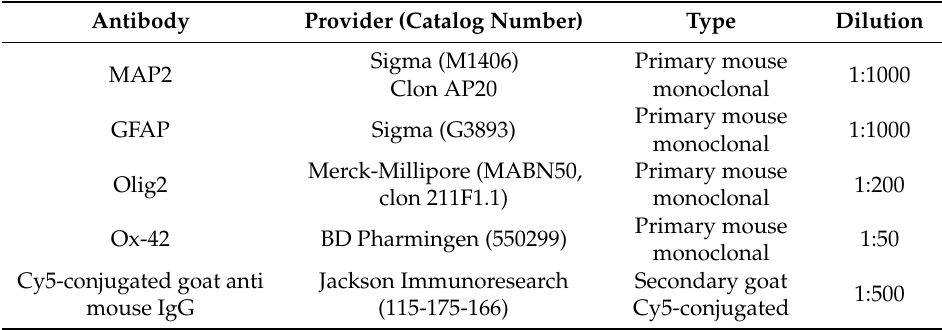
Table 1. Primary and secondary